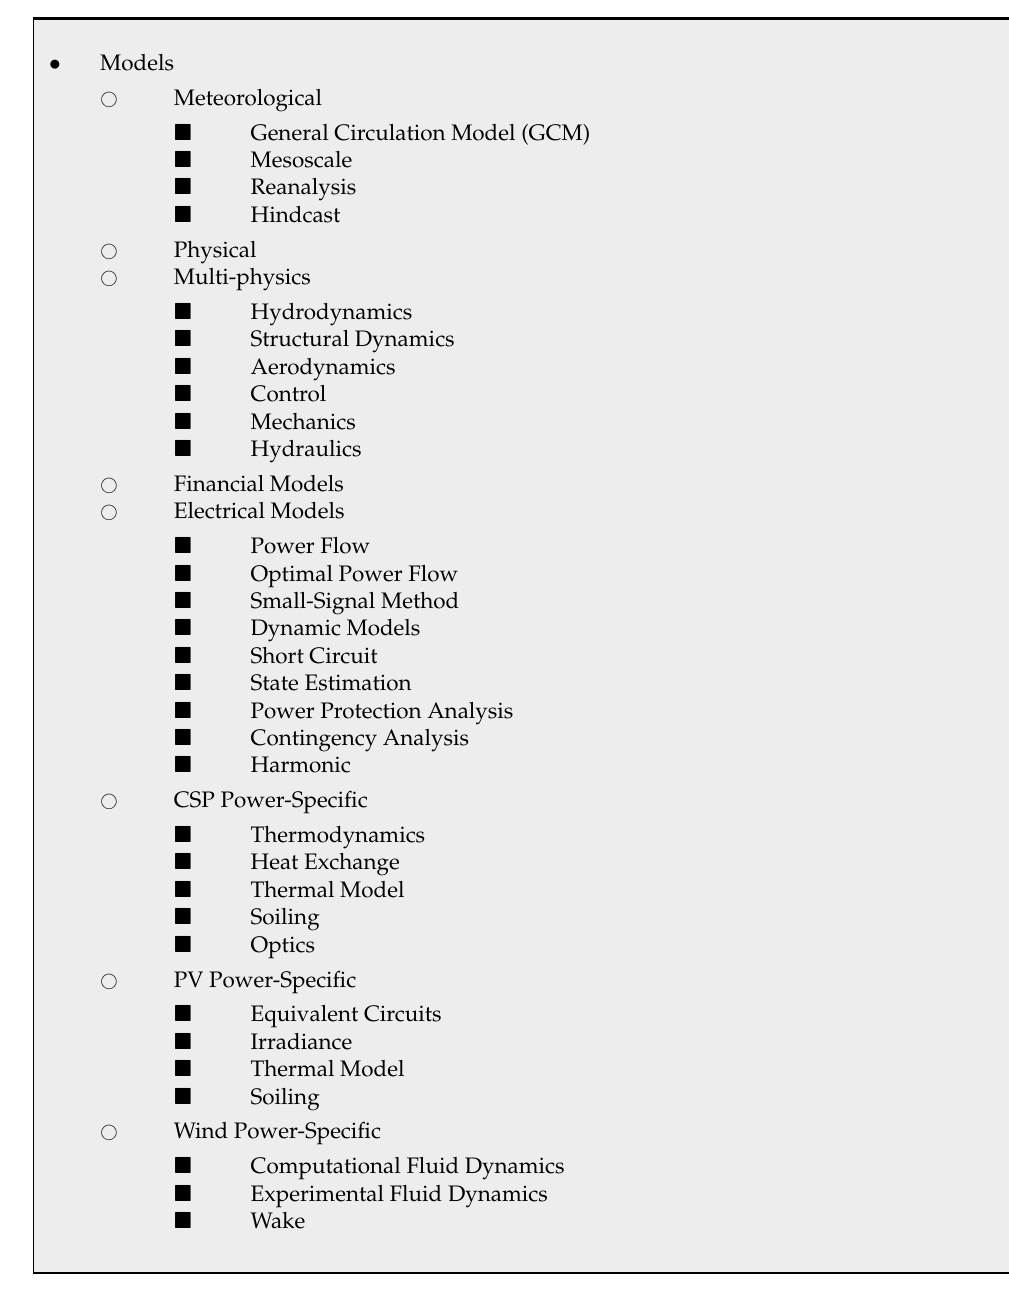
Table 21. Hierarchy for Model-related